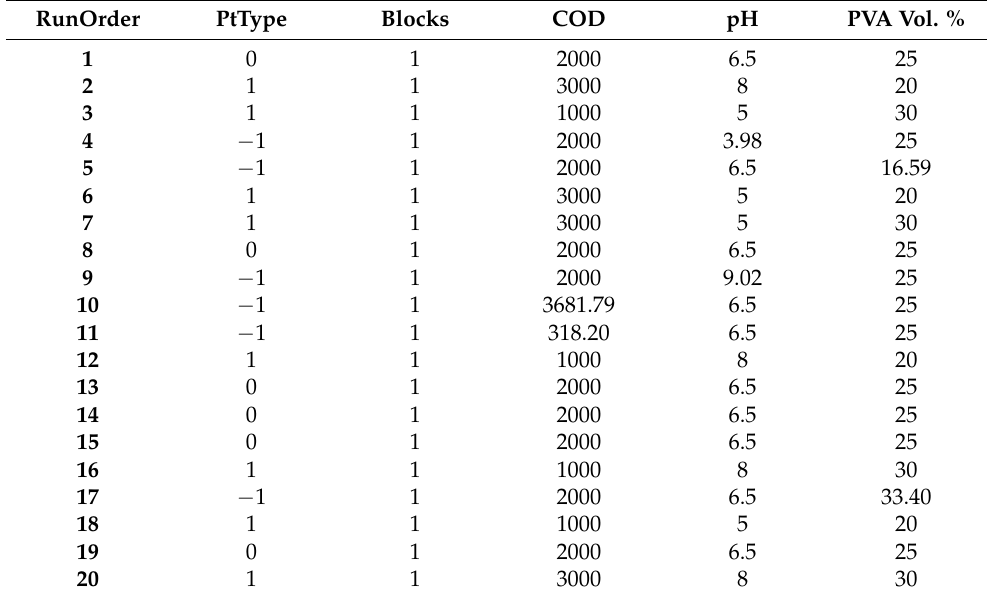
Table 4. The several parameter combinations used in the design of the GTL removal